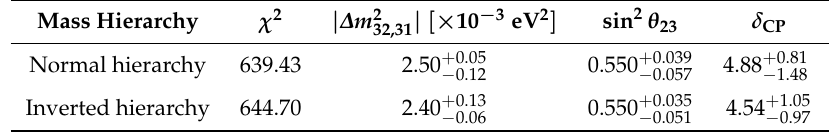
Table 3. Result of oscillation analysis combined with T2K public data